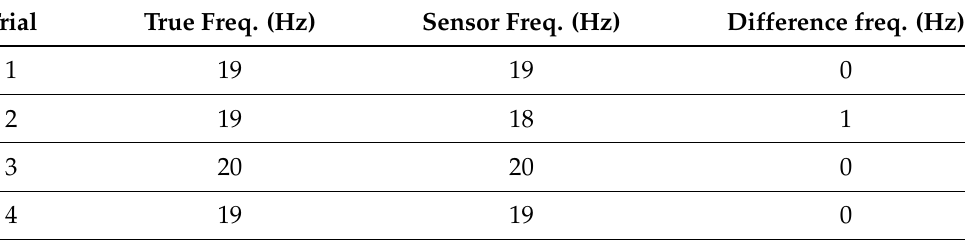
Table 3. Comparison between the frequency response of the sensor to the actual wingbeat frequency of a dragonfly obtained from high-speed camera footage. “Difference freq.” is the absolute value of the camera frequency minus the sensor